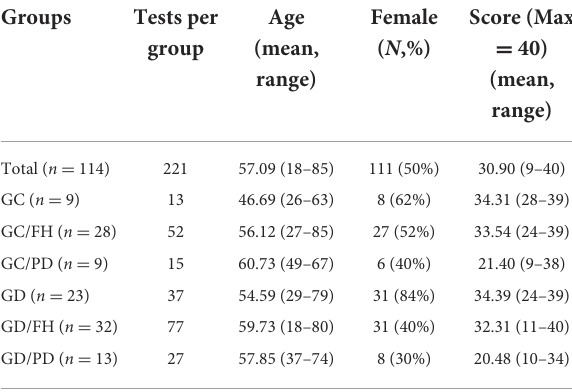
TABLE 1 Summary of cohort characteristics by